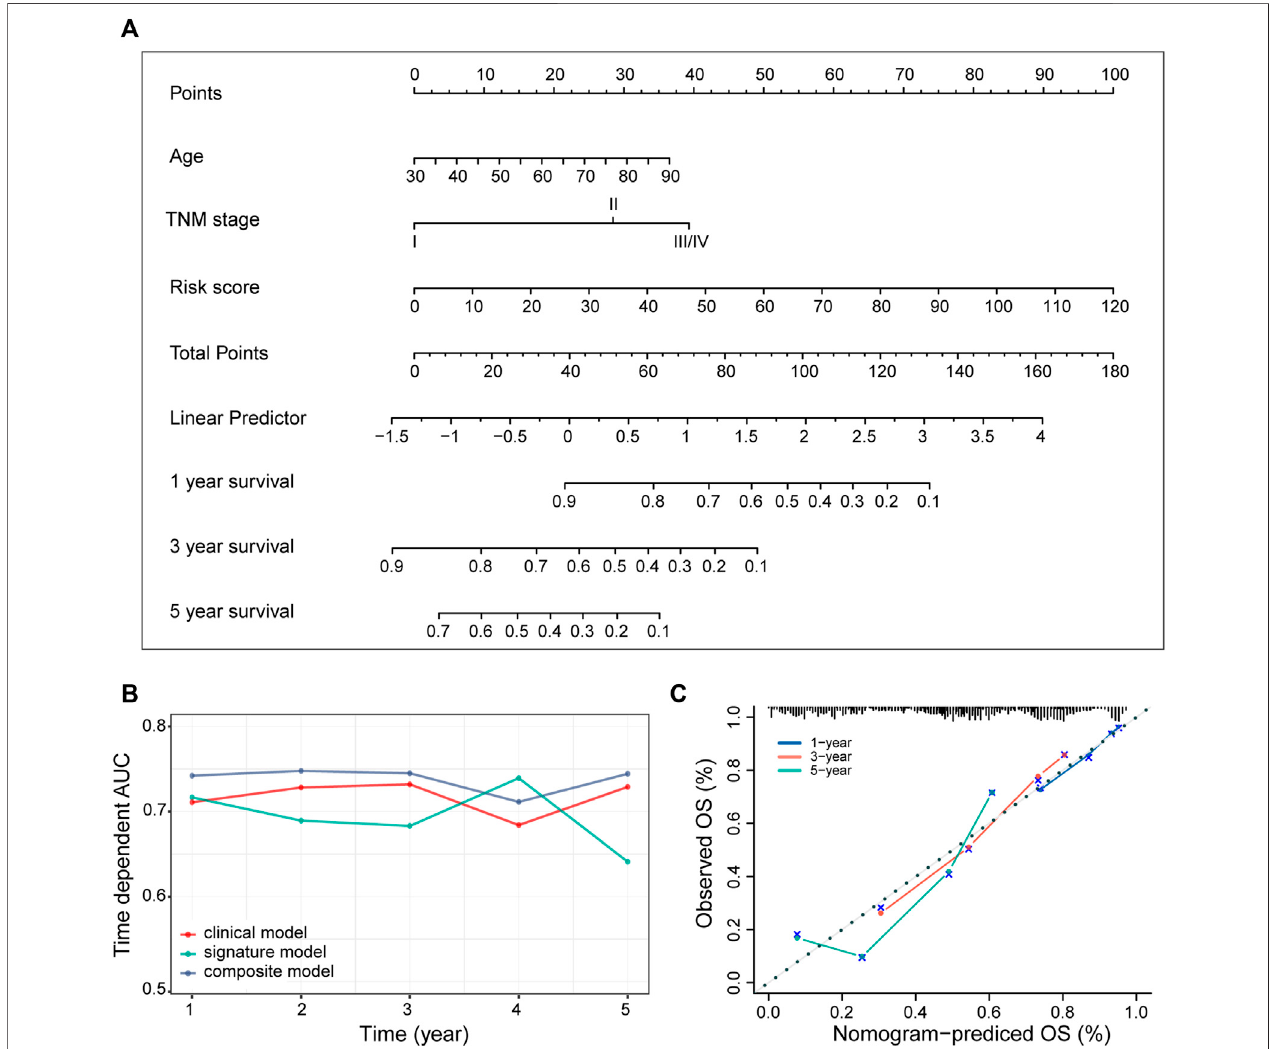
FIGURE3| Identi fi cationofthecompositeprognosticnomogram. (A) Compositenomogrampredictionof1-,3-,and5-yearOS. (B) Time-dependentAUCofROC curves for the nomogram, signature model and clinical data at different time points in the TCGA-LUAD dataset. (C) Calibration curves of observed and predicted probabilities for the nomogram in the TCGA-LUAD dataset.